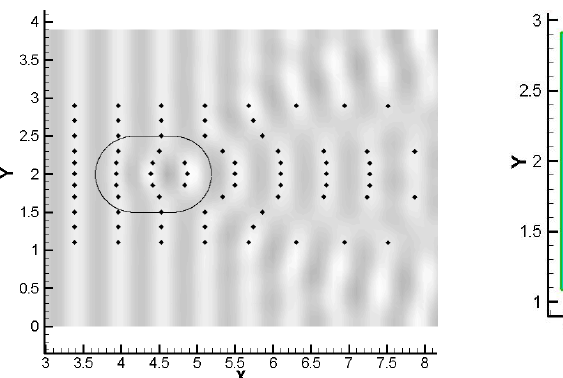
Fig. 10. Wave phase (left) and amplitude (right) measurements, T = 0 . 6s. Fig. 10: Wave phase (left) and amplitude (right) measurements, T=0.6s Table 4. Wave slopes along the